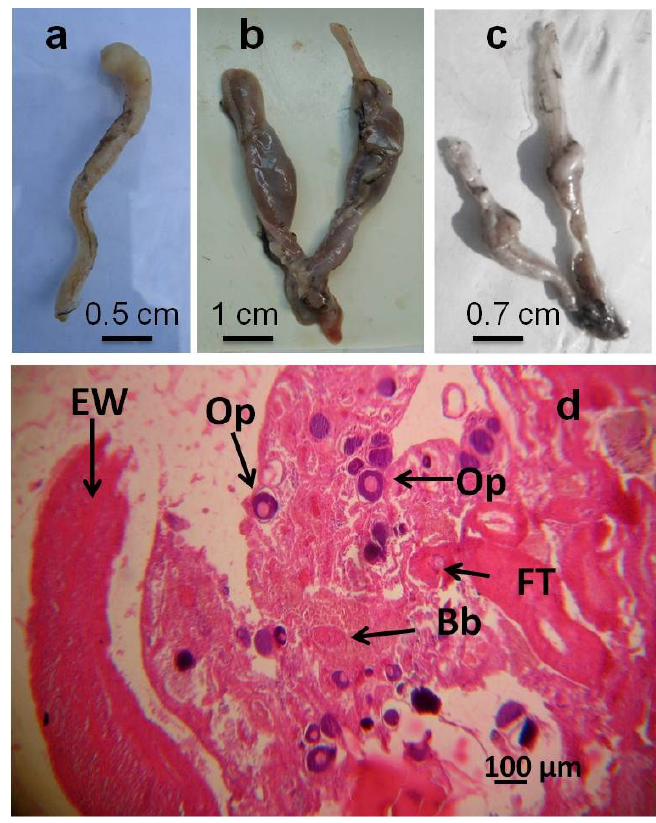
Figure 2. ( a–c ): example of irregularly shaped ovaries observed in mullets from site A of the Tiber river. Note the shape and color differences. ( d ): histological section of one of these ovaries, showing the thicked external wall (EW), the presence of primary oocytes (Op), fibrotic tissue (FT), and degenerative structures known as brown bodies (Bb), which represent a defined stage of the ovarian atretic process and indicate that gonads are in phase of